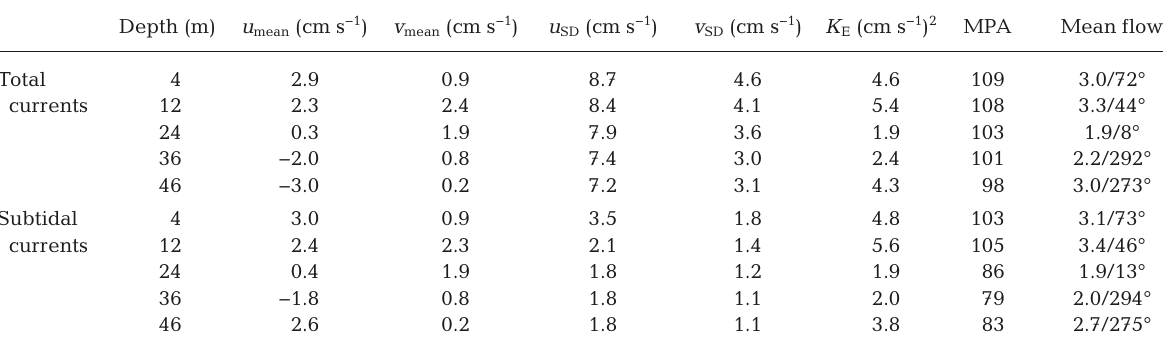
Table 1. Statistics of total and subtidal currents in Caucahue Channel during the period between 17 April and 21 July 2011. u mean and v mean ( u SD and v SD ) are the mean flow (standard deviation) of the along and cross-channel currents, respectively. K E is the kinetic energy. The orientation of the major principal axis (MPA) and mean flow (magnitude in cm s –1 /direction in degrees) are defined with respect to the geographical